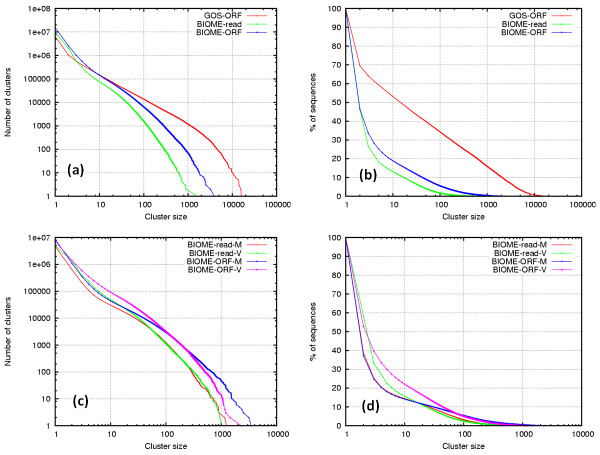
Distribution of clusters and sequences by cluster size. The x-axis is the cluster size X. The y-axis in left figures (a and c) is the number of clusters of size at least X; the y-axis in right figures (b and d) is the percentage of total sequences included in the clusters of size at least X. Clustering analyses were also made separately for the microbiomes and the viromes. So, together there are seven clustering experiments: GOS-ORF, BIOME-read, BIOME-ORF, BIOME-read-M, BIOME-read-V, BIOME-ORF-M, and BIOME-ORF-V (where M and V stand for microbiomes and viromes).